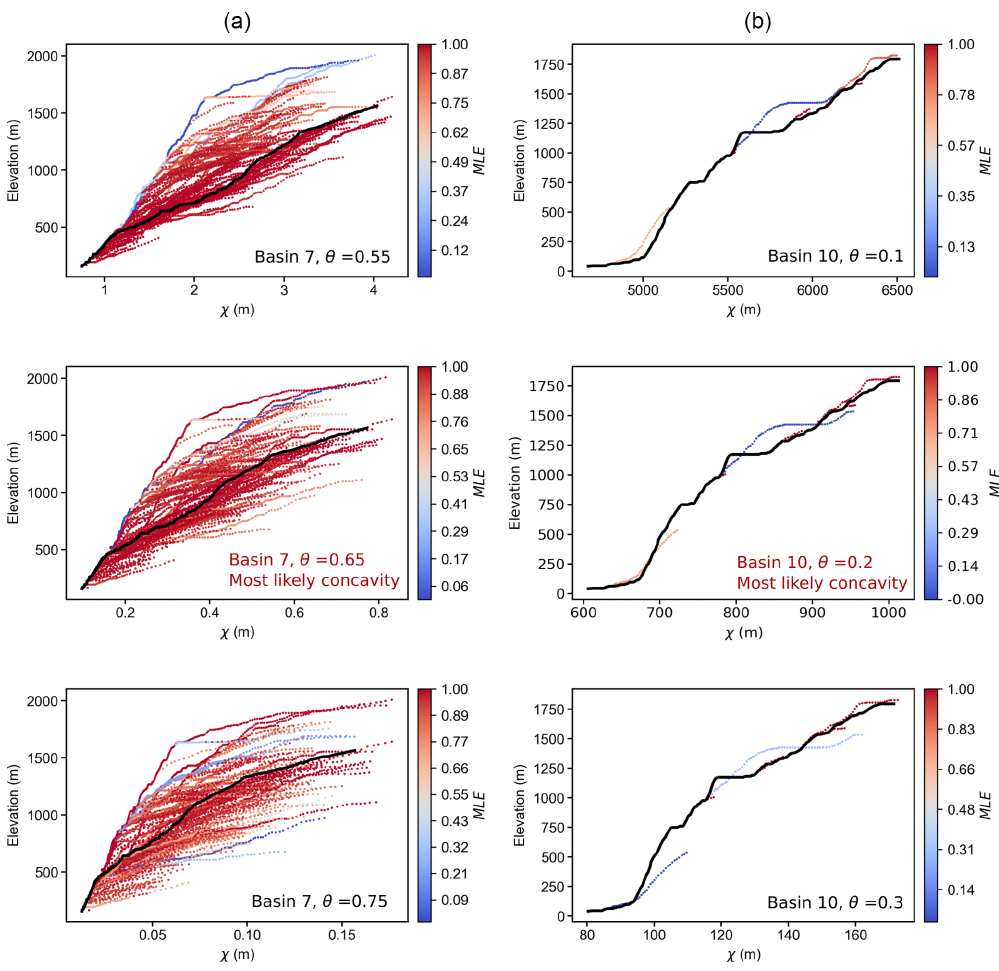
Figure 13. Profile χ –elevation plots associated with best-fit θ for basin 7, a large catchment with many tributaries draining across a relay zone between normal fault segments (column a ), and basin 10, a small, steep catchment draining directly across the footwall segment of a normal fault with few tributaries (column b ). Note that MLE values depend on both the number of nodes and the vertical offset from the trunk